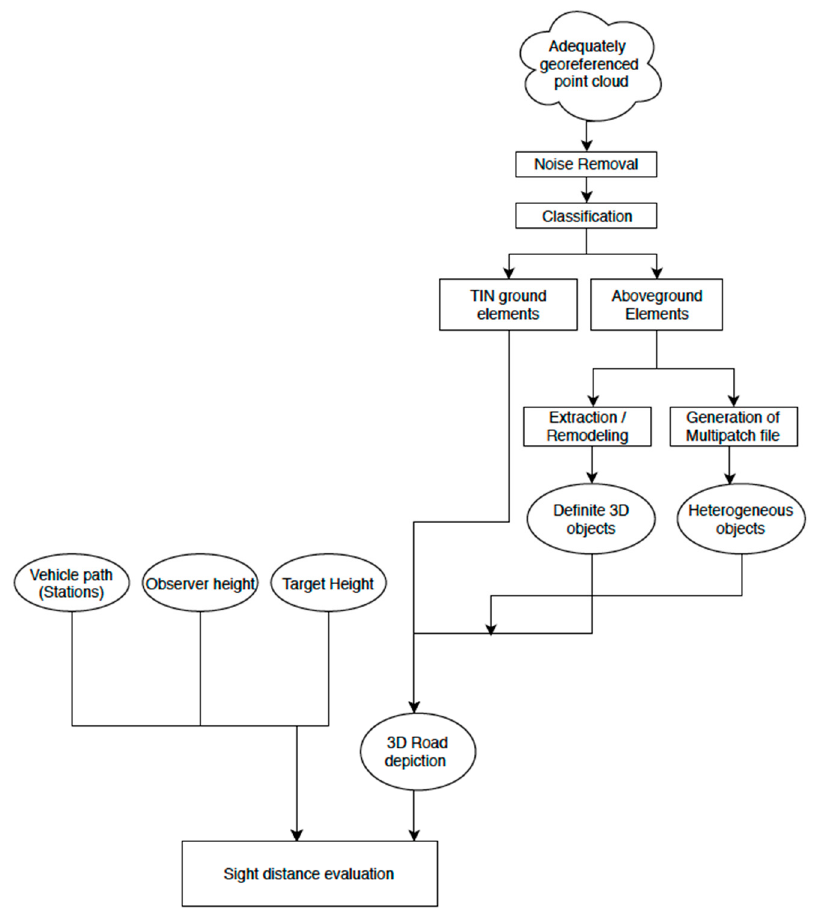
Figure 4. Description of the presented method.